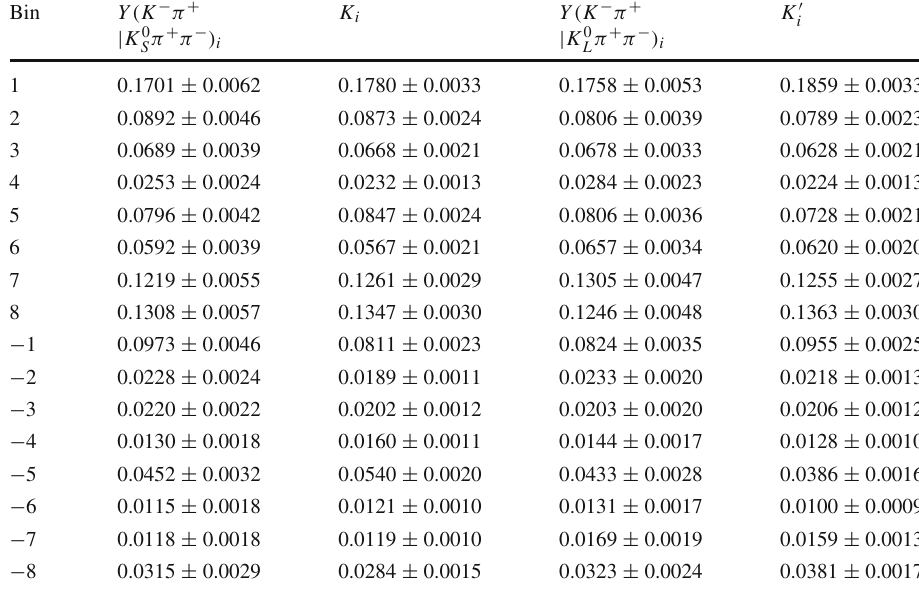
( (cid:7) ) π + π − , calculated with no D → K − π + inputs. For each value the first uncertainty is statistical and and s for D → K 0 i i S , L